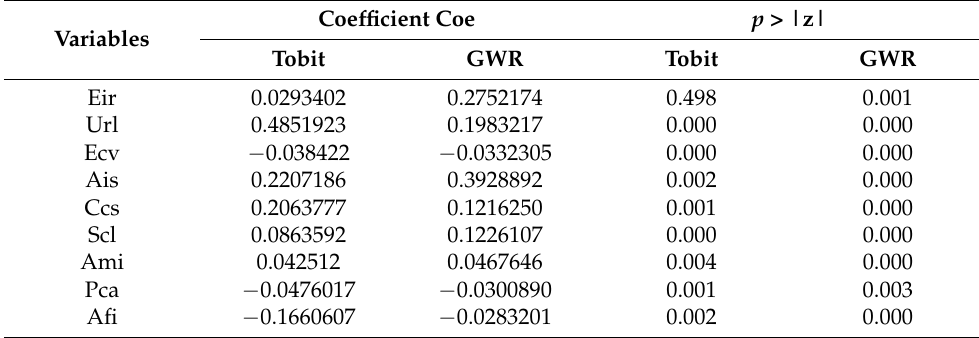
Figure 4. Spatial distribution of AEE clusters in the YRD region in four time periods. Table 5. Regression results of factors influencing AEE from 2000 to